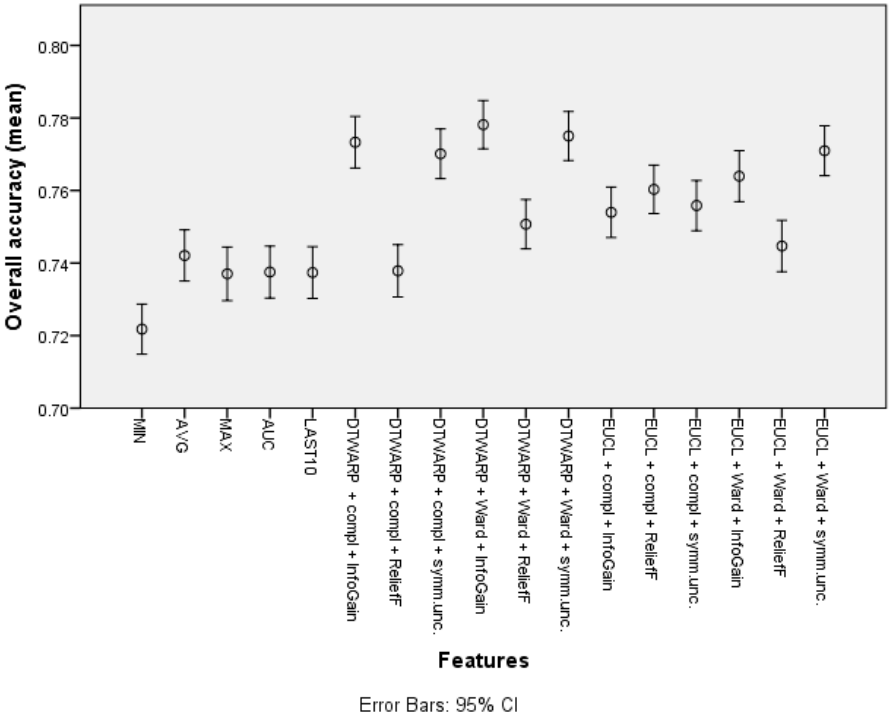
Figure 5. The overall accuracy of Naïve Bayes classifiers: mean values and 95% confidence intervals.